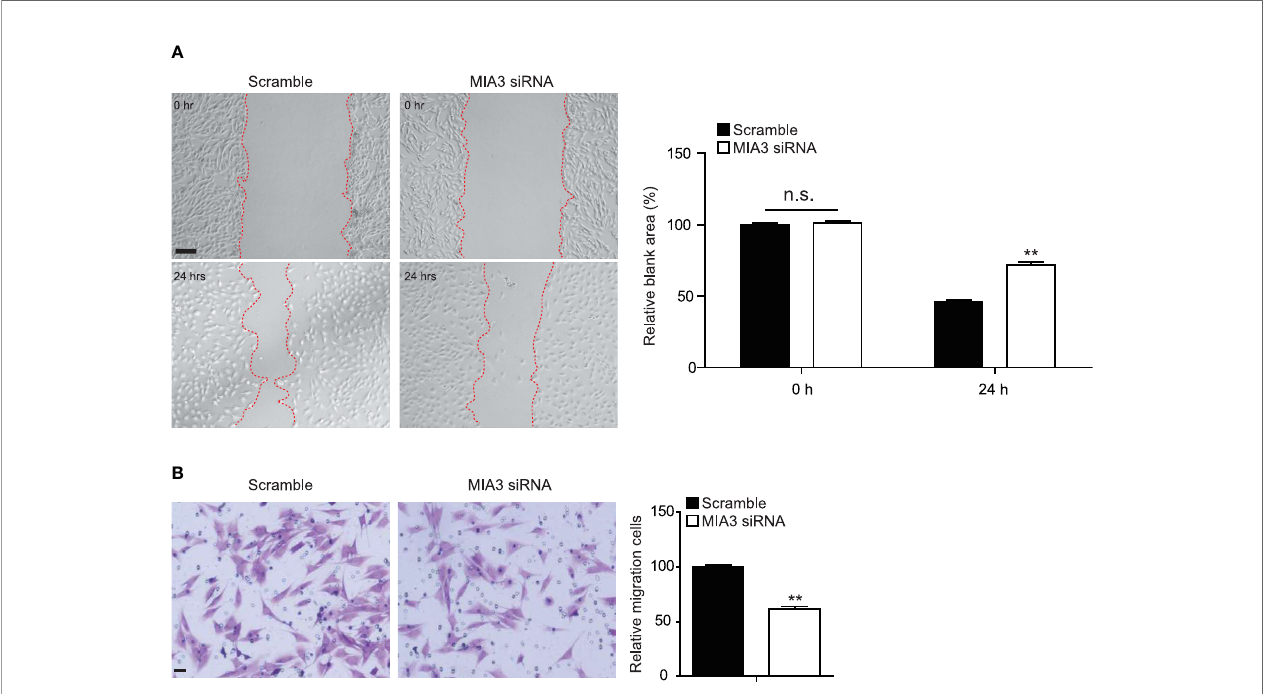
FIGURE 3 | Knockdown of MIA3 inhibits vascular smooth muscle cell (VSMC) migration. (A) The wound-induced cell migration assay was performed in VSMCs with or without transfection of MIA3-speci fi c small interfering RNA. The relative blank wound areas in the left were quanti fi ed on the right. Scale bar: 100 m m. Data are represented as the mean ± SEM, n = 3. n.s. indicates nonsigni fi cant. ** p < 0.01, t -test. (B) The transwell assay in VSMCs with MIA3 siRNA or scramble siRNA. The transferred and stained cells were counted on the right. Scale bar: 50 m m. Data are represented as the mean ± SEM, n = 3. t